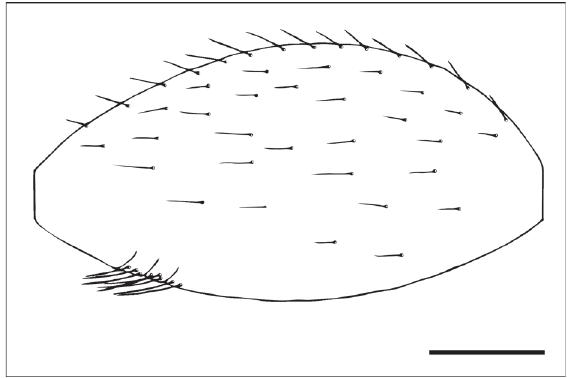
Figure 2. Tibia II, lateral view, Hershkovitzia mariae sp. nov. (Scale bar = 1 mm